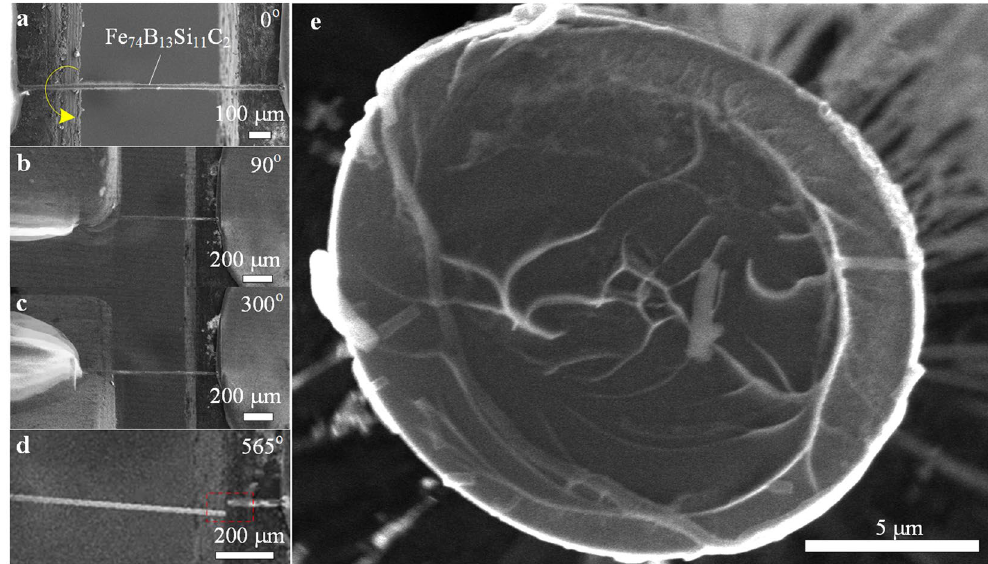
Figure 3. Twisting test of magnetic microwire. ( a ) The microwire is assembled on the two sample holders of iTRo with gauge length approximate 1400 μ m. ( b ) and ( c ) gives SEM images at twisting angle 90° and 300° respectively. ( d ) Microwire is broken at twisting angle 565°. ( e ) SEM image of the fracture plane, indicating it’s a typical ductile failure caused by shear stress.